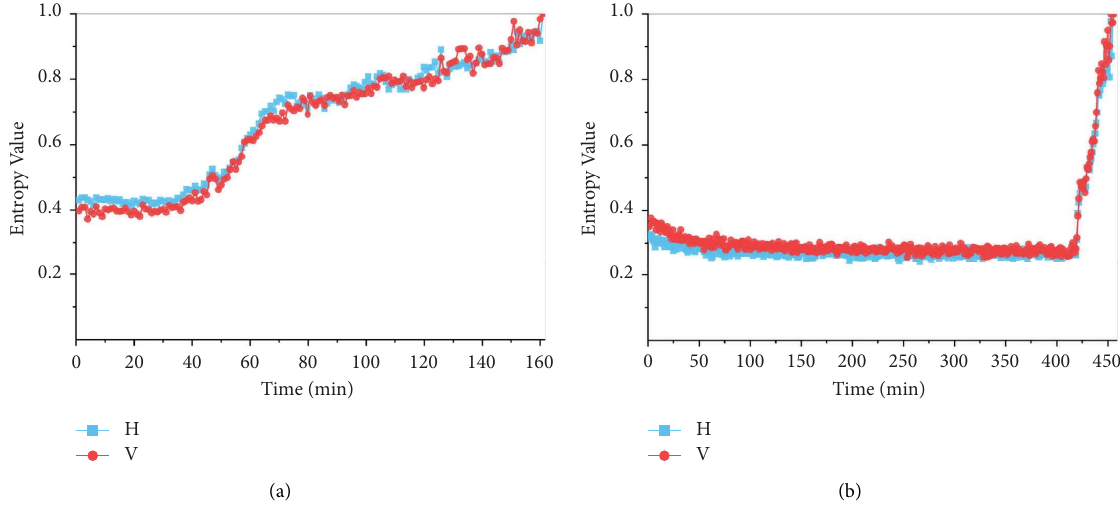
Figure 9: Bearing Shannon entropy. (a) Bearing 1-2. (b) Bearing